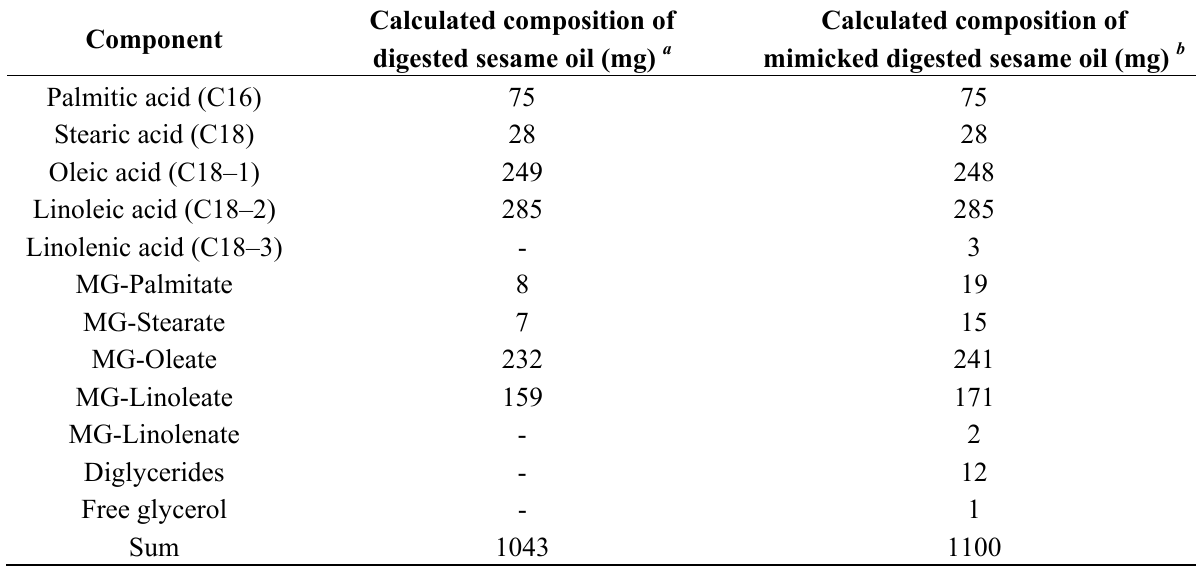
Table 9. Calculated composition of digested sesame oil and calculated composition of the mimicked digested sesame